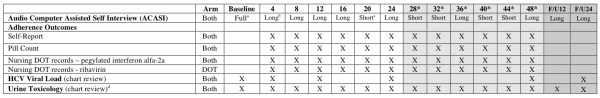
Schedule of research visits. * Subjects treated and followed for 48 weeks only (HCV monoinfected - G1/4; HIV/HCV coinfected - all genotypes). a) Full Baseline ACASI survey includes measures of: adherence [33]; opiate withdrawal [34]; recent drug and alcohol use [5,35]; alcohol dependence [36]; HCV-related adherence knowledge [5,37]; attitudes towards HCV medications [5,37]; adherence self-efficacy [5,37]; medication side effects [5]; coping [38]; depression (BDI-II and PHQ-9)[39-41]; psychological distress (hostility subscale)[42-44]; loneliness [45]; social support [46]; acculturation [47,48]; patient-provider relationship [49]; cognitive function [50-52]; Barriers and Facilitators to Care [37]. b) Long ACASI survey includes measures of: adherence [33]; opiate withdrawal [34]; on-site social support; depression (BDI-II and PHQ-9)[39-41]; psychological distress (hostility subscale)[42-44]; recent drug and alcohol use [5,35]; medication side effects [5]; HCV-related adherence knowledge (wks 8 and 16 only) [5,37]; attitudes towards HCV medications (wks 8 and 16 only)[5,37]; adherence self-efficacy (weeks 8 and 16 only) [5,37]. c) Short ACASI survey includes measures of: adherence [33]; depression (BDI-II and PHQ-9)[39-41]; medication side effects [5]; opiate withdrawal [34]. d) Urine tested for methadone, opiates, cocaine, benzodiazepines, barbiturates, and amphetamines.